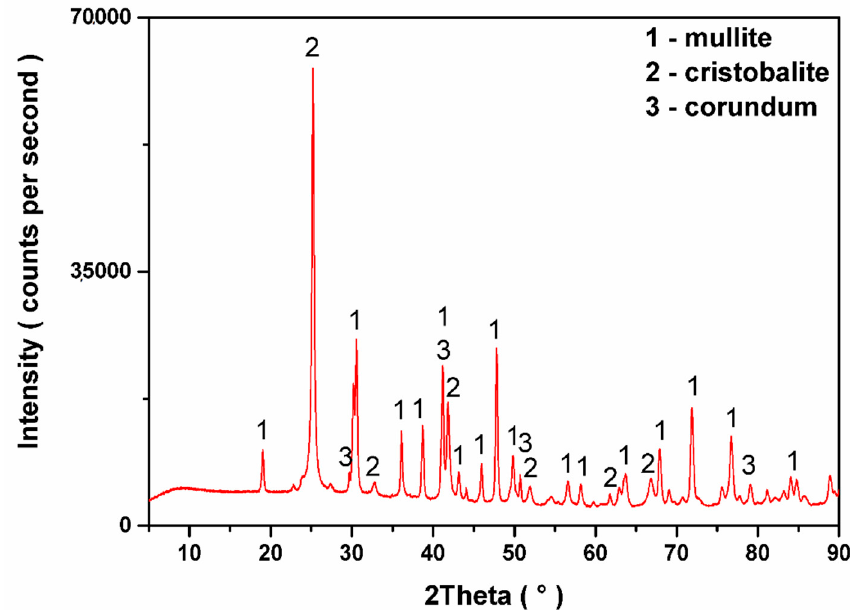
Figure 7. XRD patterns calcined at 1400 °C—mullite, α -Al 2 O 3 , cristobalite.